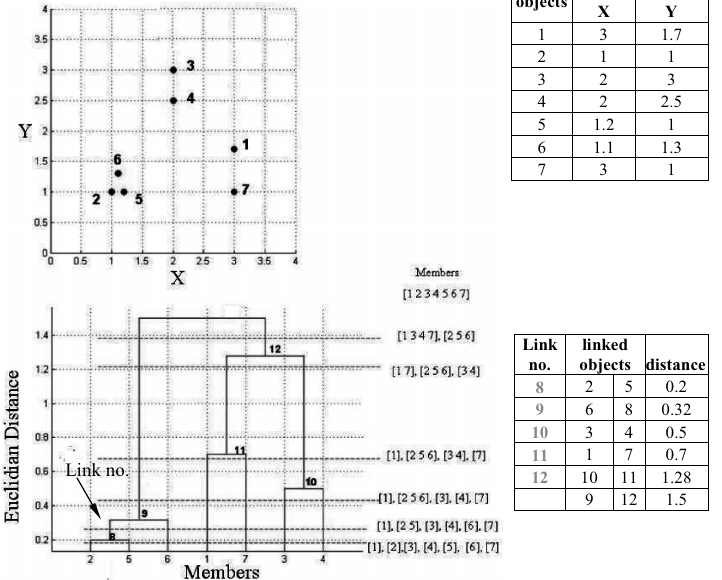
Fig. 2. Hierarchical clustering, single